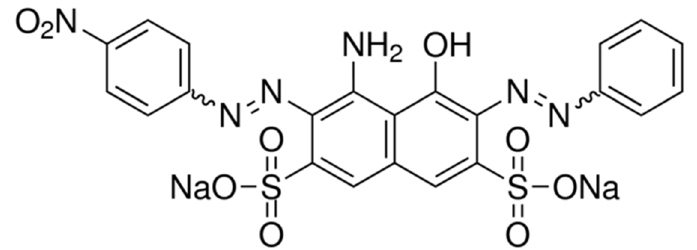
Figure 1. Naphthol blue black molecule.